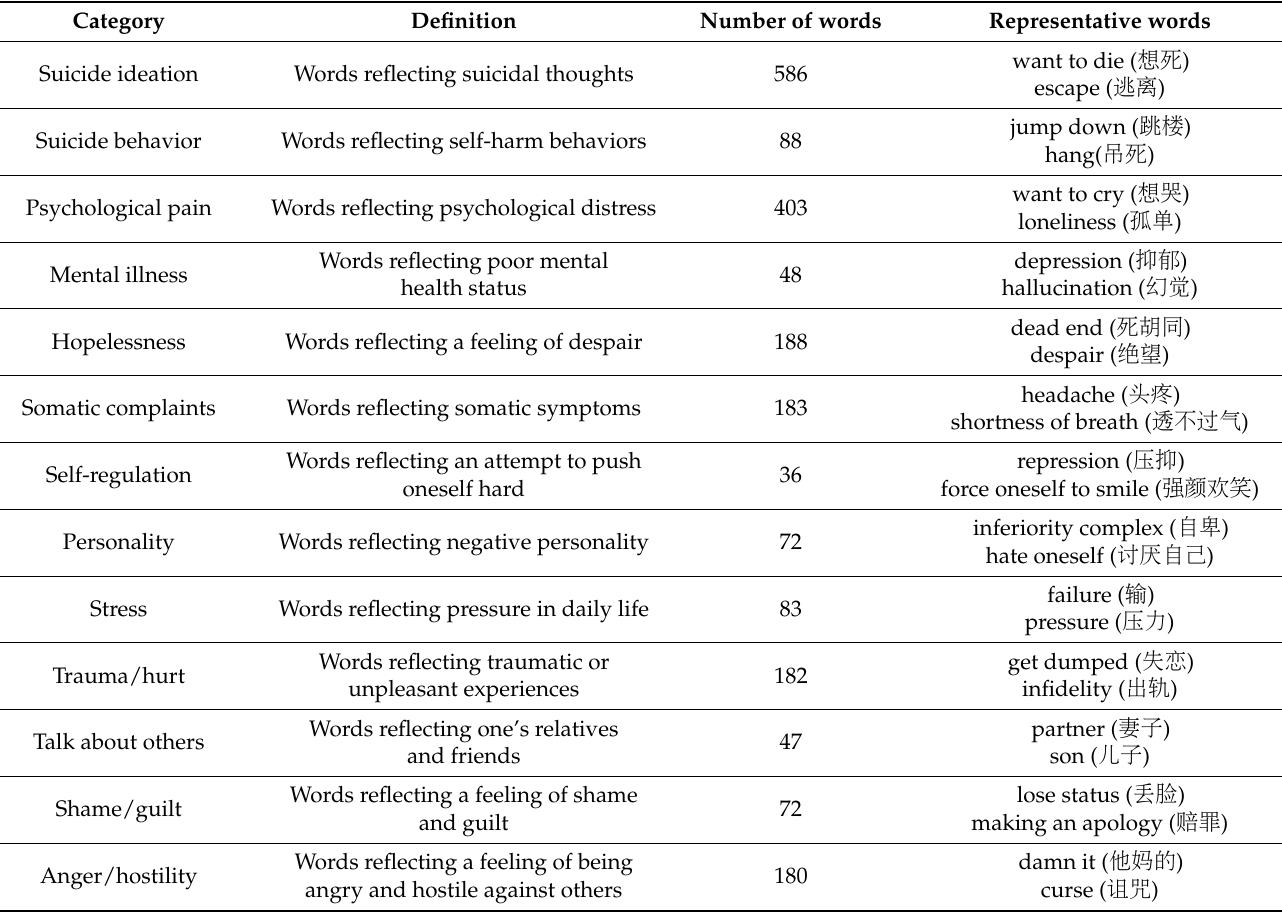
Table 1. Chinese suicide dictionary